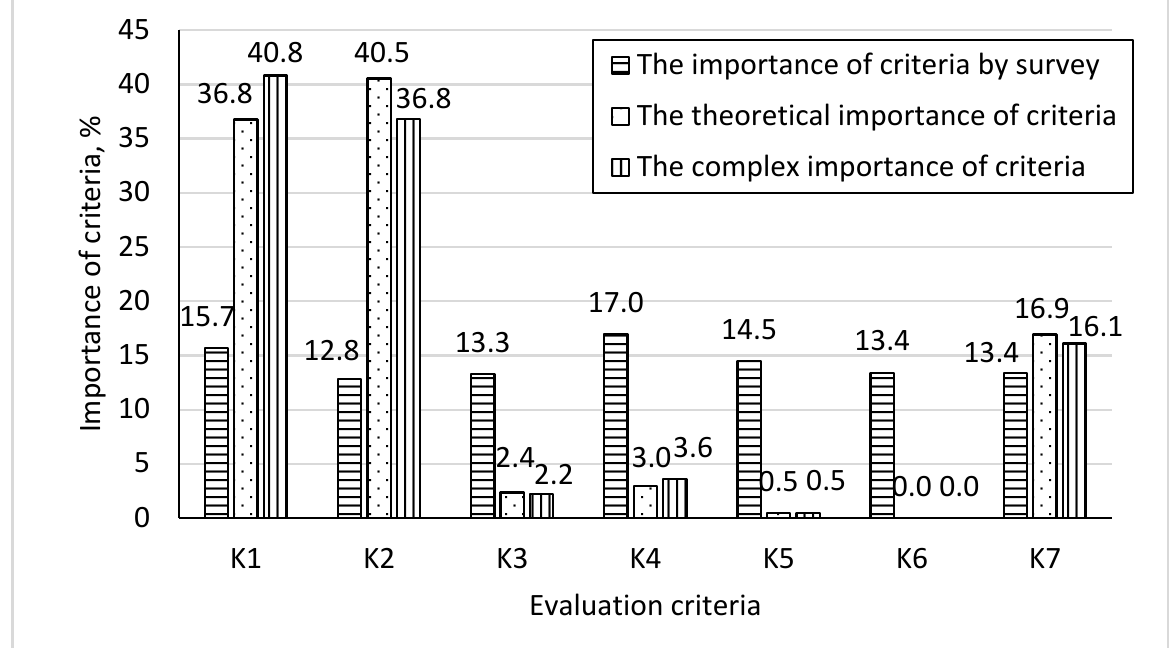
Figure 8. The importance of the evaluation criteria obtained by different methods.